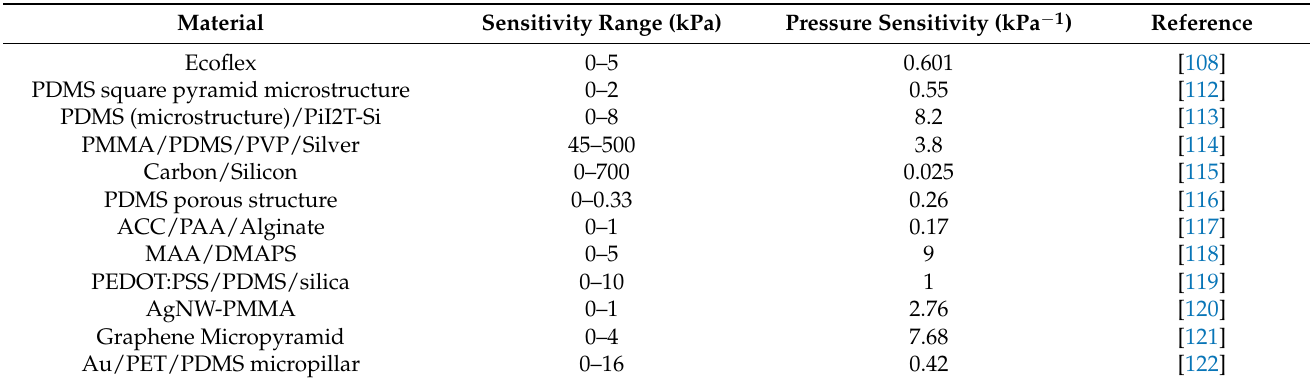
Table 1. Reported sensitivity ranges and pressure sensitivity values for the flexible capacitive